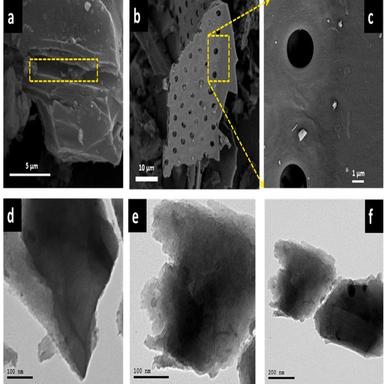
(a, b, and c) FESEM and (d, e, and f) TEM images of Ach sample.